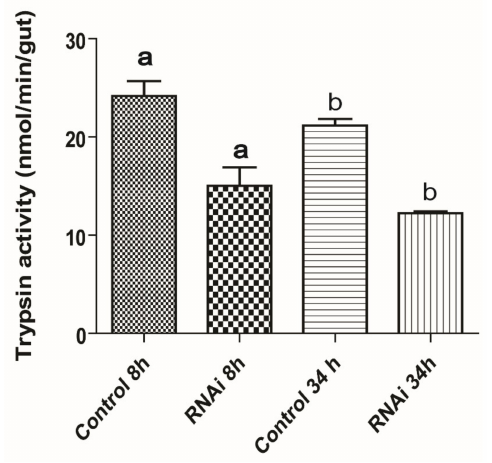
Figure 6. The effect of feeding Aea ABC-TMOF receptor dsRNA to female mosquitoes. Groups of female Ae. aegypti (five female/group) were fed on 5% sucrose and 0.2% BSA solution